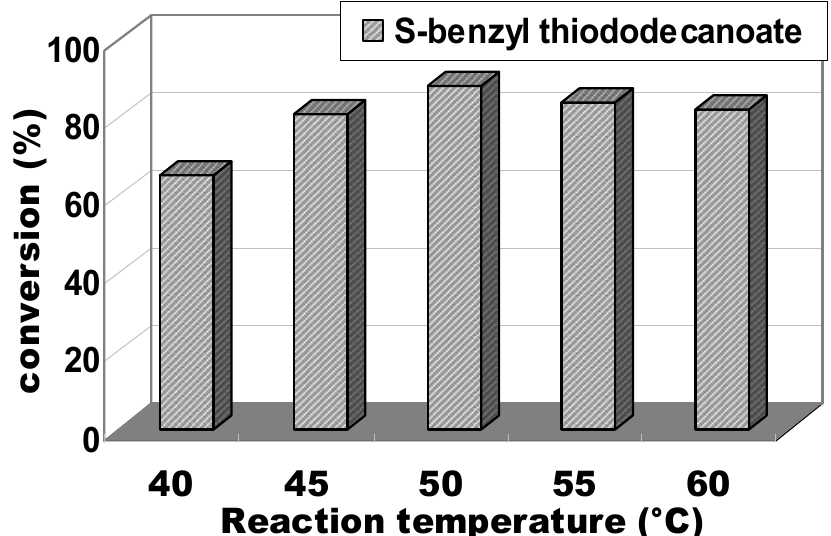
Figure 3. The influence of reaction temperature (°C) on the enzymatic synthesis of thioesters in a continuous flow microreactor: 10.4 µL min −1 feed 1 (4 mmol thiol derivatives in 10 mL DMSO) and 10.4 µL min −1 feed 2 (8 mmol vinyl esters in 10 mL DMSO) at different reaction temperature (residence time 30 min), Lipozyme TL IM (0.87 g, 44 mg mL −1 ).